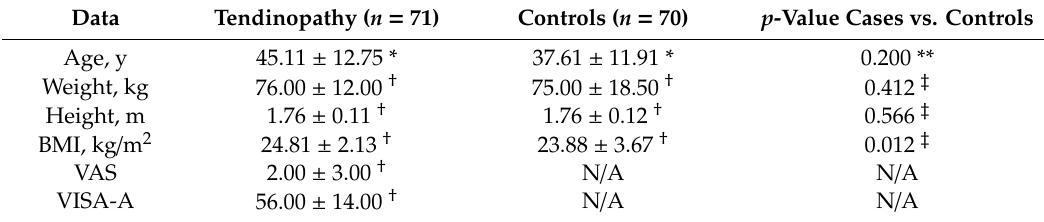
Table 1. Sociodemographic data, pain scores, and VISA-A scale of the sample.